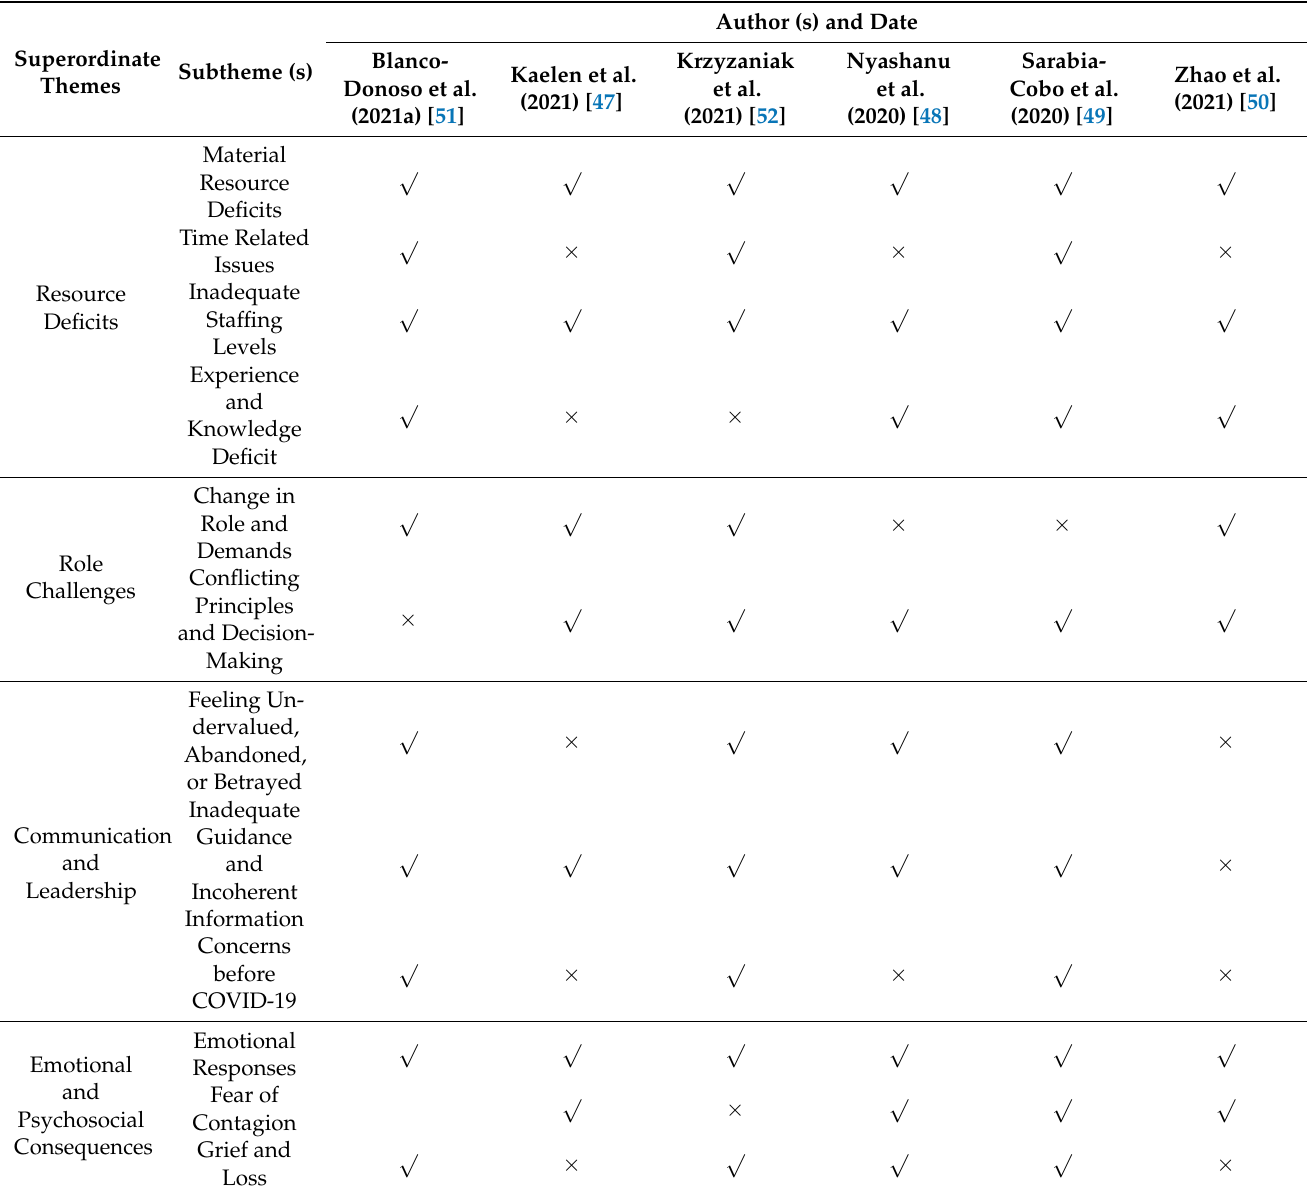
Table 6. Occurrence of superordinate themes and subthemes in selected